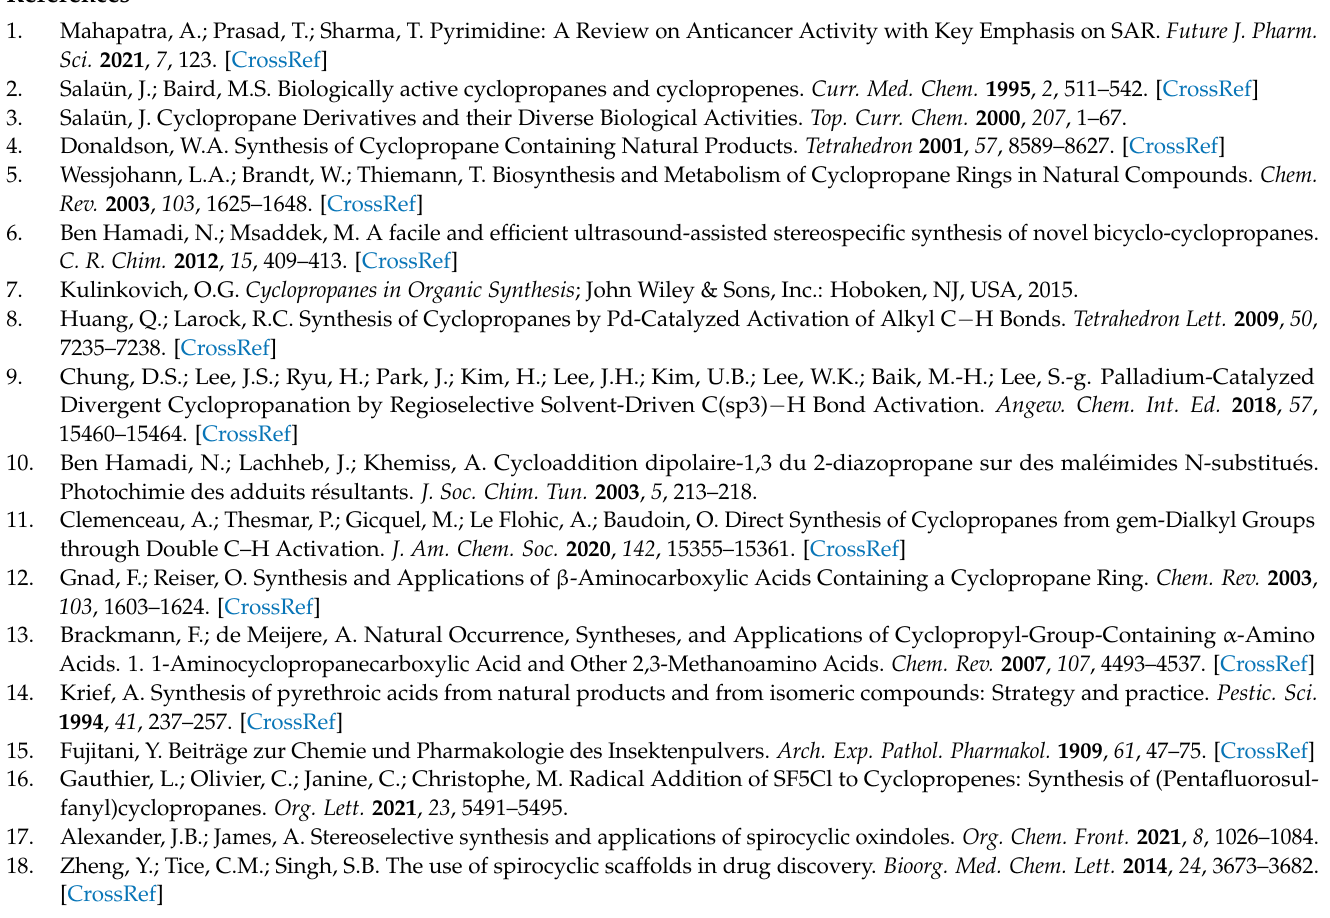
Figure S16: 1H-NMR spectrum of compound 5b recorded in CDCl3, Figure S17: 13C-NMR spectrum of compound 5b recorded in CDCl3, Figure S18: HRMS mass spectrum of compound 5b , Figure S19: 1H-NMR spectrum of compound 5c recorded in CDCl3, Figure S20: 13C-NMR spectrum of compound 5c recorded in CDCl3, Figure S21: HRMS mass spectrum of compound 5c , Figure S22: 1H-NMR spectrum of compound 5d recorded in CDCl3, Figure S23: 13C-NMR spectrum of compound 5d recorded in CDCl3, Figure S24: HRMS mass spectrum of compound 5d